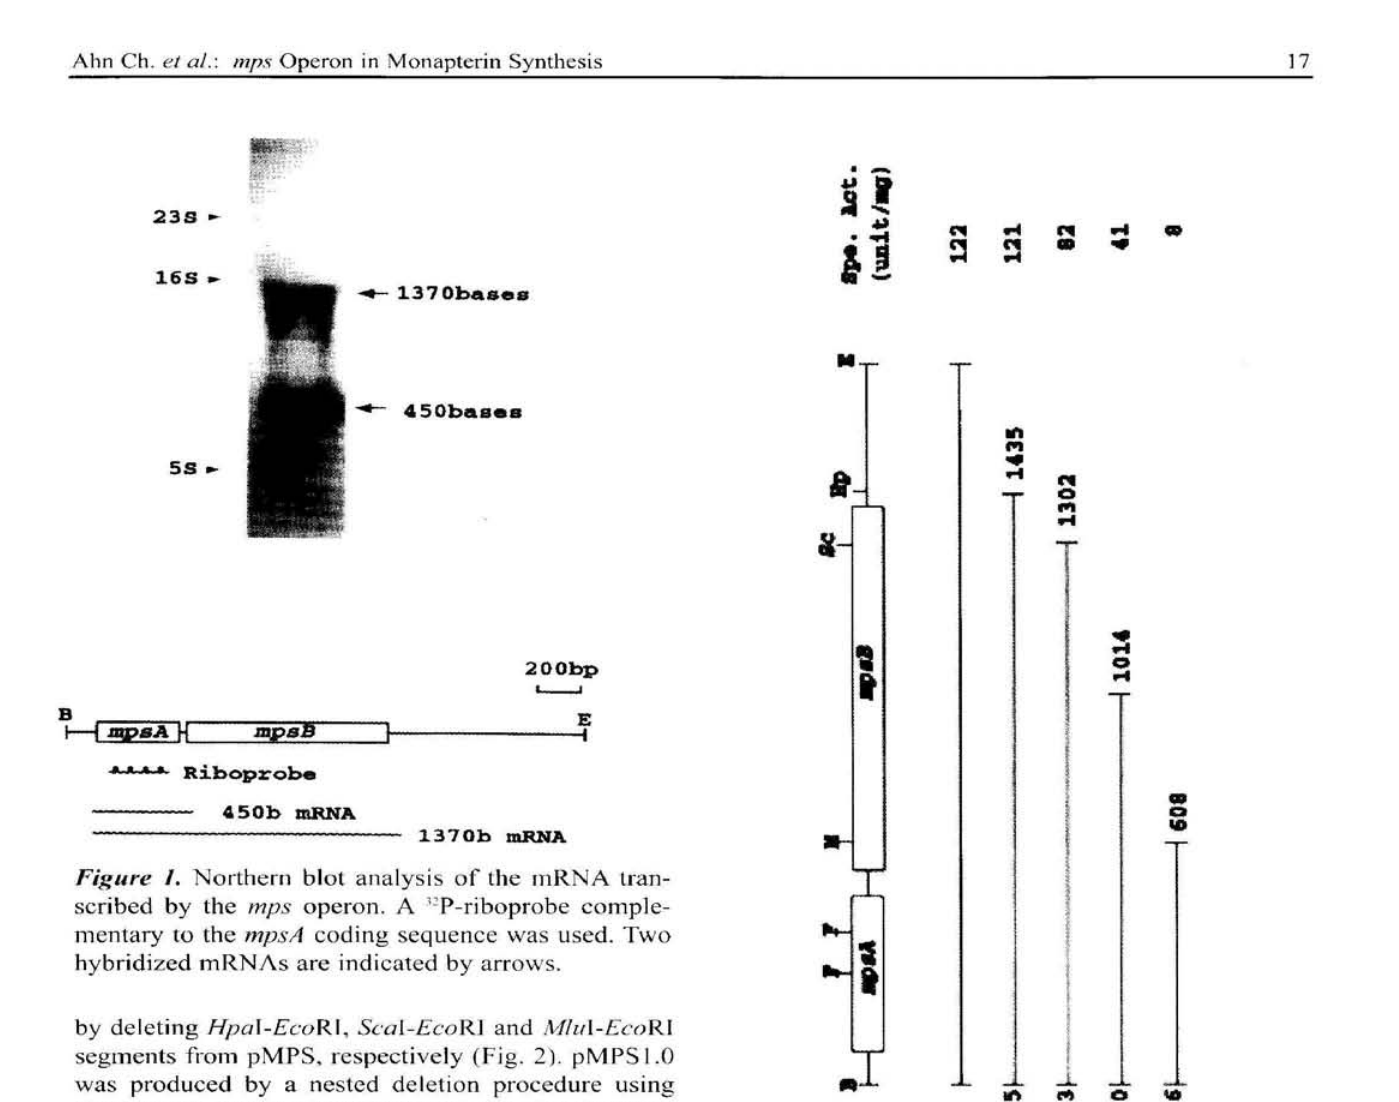
Figure 2. Deletion analysis for 3' downstrcam region of the mpsA gene in pMPS. Construction of the dele- tion Plasmids is described in the text. The numbers at the right of the bars indicate the end point of the dele- tion calculated from the BamH\ site. One enzyme unit is defined as the amount of epimerase that catalyzes the fonnation of 1 pmol Hj-monaptcrin triphospha-